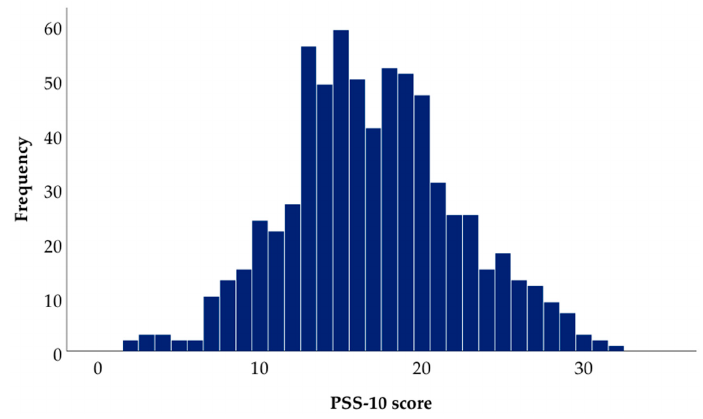
Figure 2. Histogram of the Perceived Stress Scale 10 (PSS-10) score in the overall study sample ( n = 689). Table 1. Socio-demographic and socioeconomic factors associated with perceived stress in the study sample.